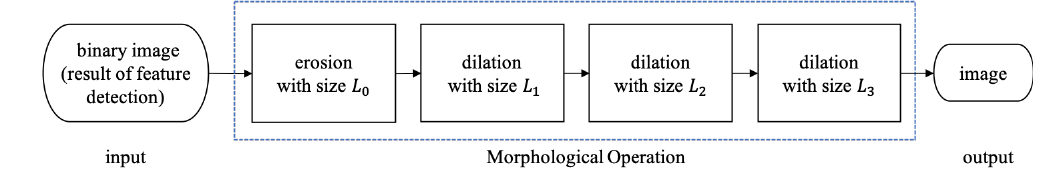
Figure 7. Morphological operation method designed in our